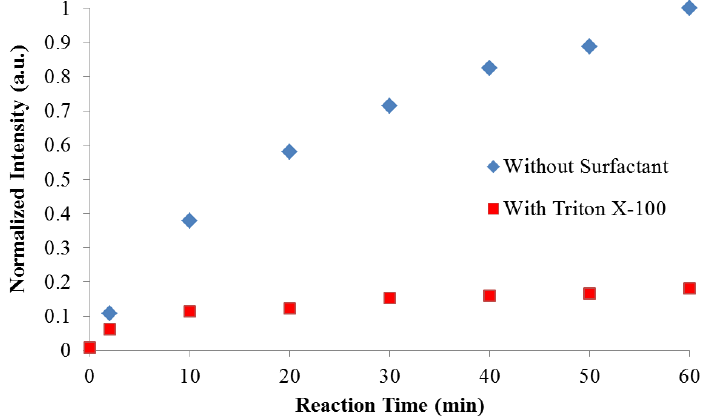
Figure 6. Rate of Normalized Emission Growth at 465 nm during Polymerization (λ ex = 350